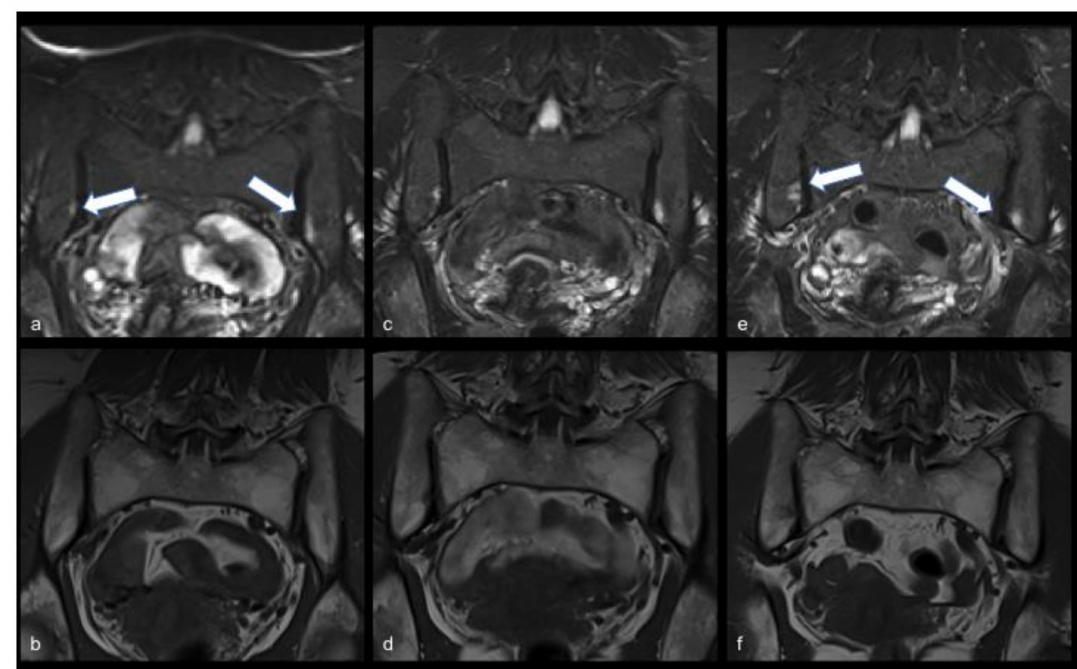
Figure 1. Case report 1. Persistent MRI findings suggestive of bilateral active sacroiliitis in a 58-year-old patient with lower back pain. On the first MRI examination, subchondral bone marrow oedema at the iliac side of both sacroiliac joints was found, appearing as band-like hyperintensity on short-tau-inversion recovery (STIR) T2-weighted semi-coronal image (arrows in ( a )) with corresponding hypointensity on turbo-spin-echo (TSE) T1-weighted semi-coronal image ( b ). Oedema was found to persist at a second MRI examination performed one month later ( c , d ), and increase after six more months ( e , f ), especially on STIR T2-weighted image (arrows in ( e )).